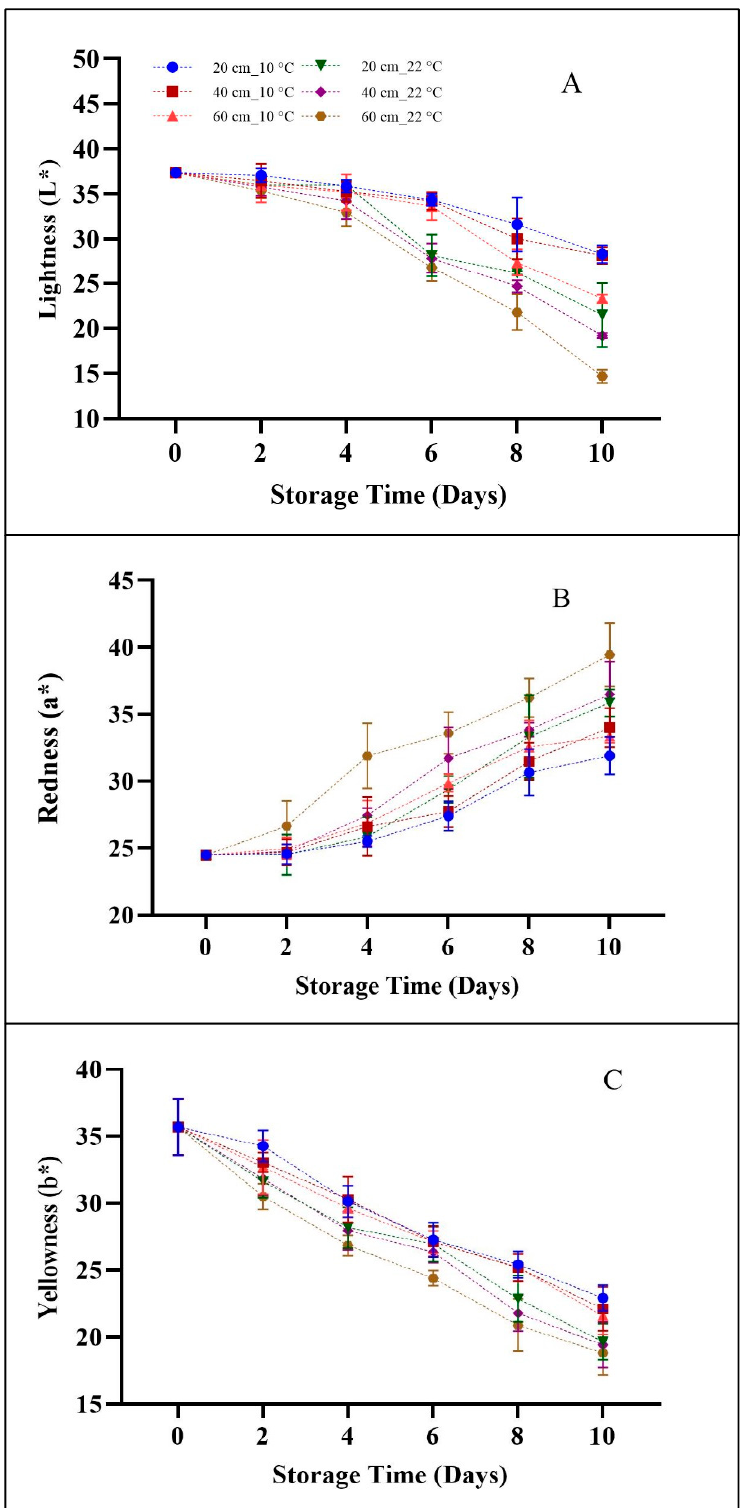
Figure 8. Lightness ( A ), redness ( B ), and yellowness ( C ) of the tomato impacted at different drop heights (20 cm, 40 cm, and 60 cm) and stored for 10 days at 10 °C and 22 °C storage conditions. Error bars represent the standard deviation (SD) of the mean values ± S.D. of 18 readings of three replicates.